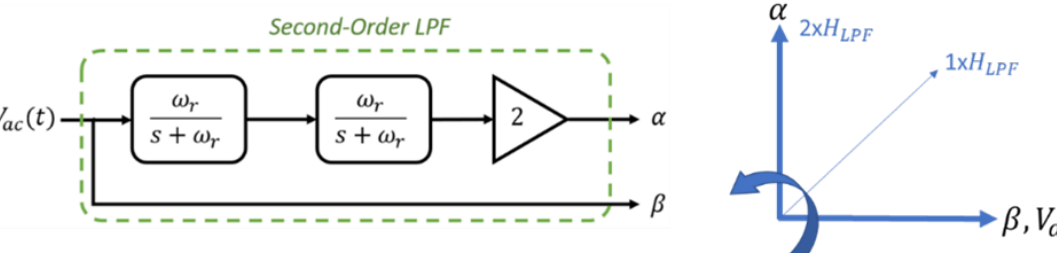
Figure 4. Effect of first-order low-pass type filters, each at grid frequency, on the phase of the grid-side AC voltage